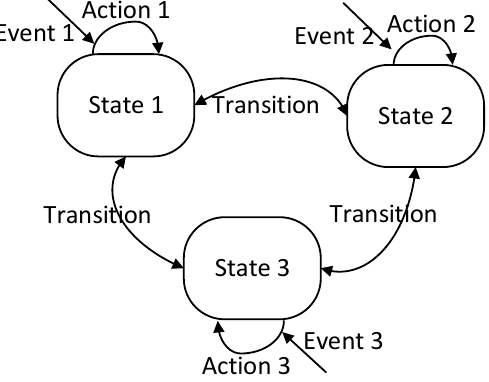
Figure 3. Principle of state machine.